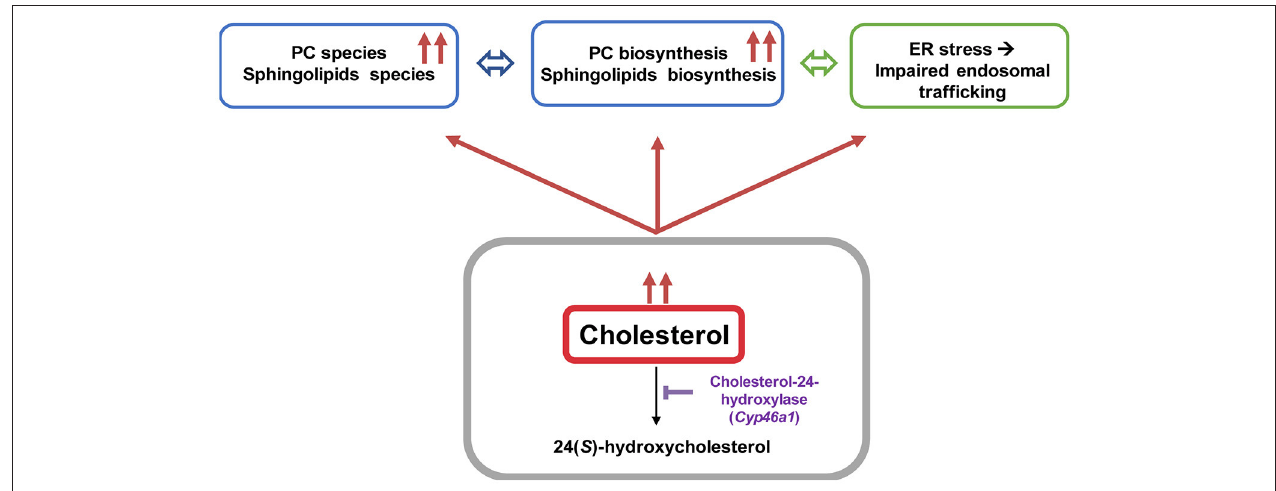
FIGURE 8 | Cholesterol overload in neurons induced by Cyp46a1 down-regulation in mice hippocampus disrupts lipid metabolism and lysosomal